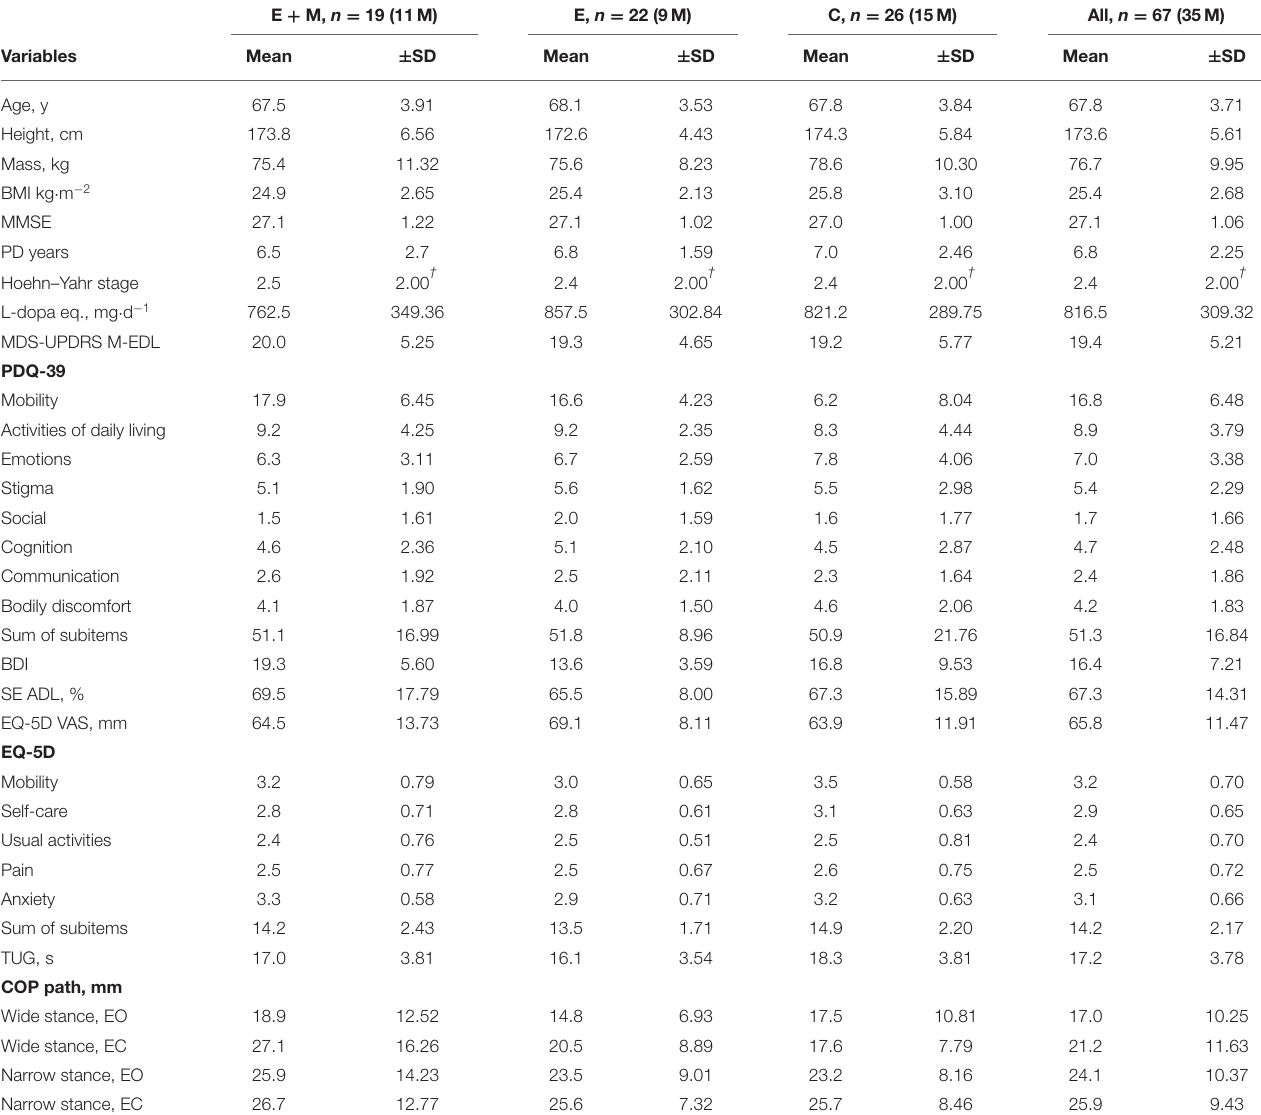
TABLE 1 | The characteristics of the patients at